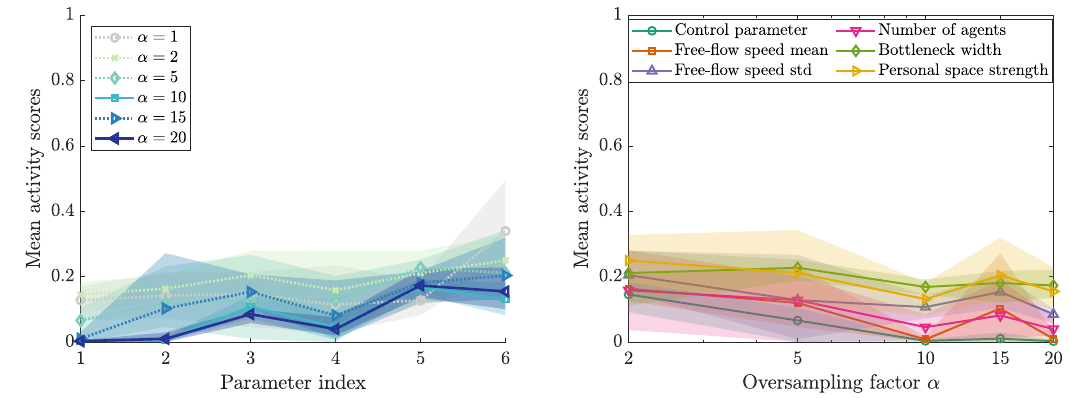
Figure A5. Activity scores for the new range of the personal space strength parameter. Runs that identify a one-dimensional subspace are shown with solid lines, in some runs a 5-dimensional subspace is identified (dotted). The parameter index is mapped as follows: 1—control parameter, 2—free-flow speed mean, 3—free-flow speed standard deviation, 4—number of agents, 5—bottleneck width, 6—personal space strength.